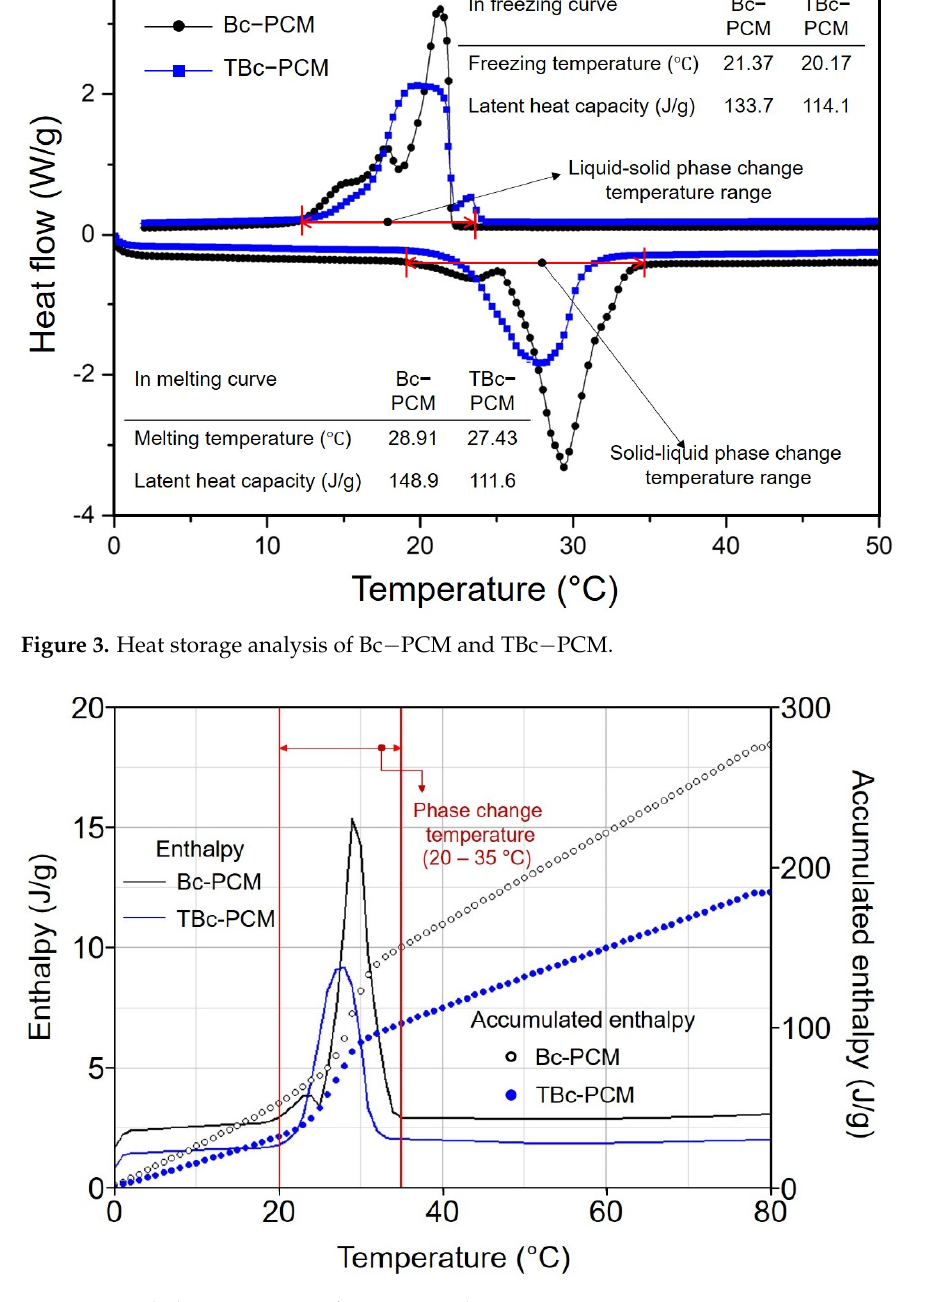
Figure 5. Thermal durability analysis of Bc-PCM and TBc-PCM. 3.3. Energy Simulation Analysis 3.3.1. Annual Heating and Cooling Load Reduction Table 4 represents the annual heating and cooling energy consumption of the building models in which Bc-PCM and TBc-PCM were applied with thicknesses of 10 to 30 mm for the four cities. In this study, the reference model represents a conventional wooden frame house in which Bc-PCM and TBc-PCM are not applied to the wall. In Design Builder, the energy consumption of the building was estimated based on gas consumption for heating and electricity consumption for cooling. As shown in Table 4, the annual heating and cooling energy consumption shows a lower heating and cooling energy consumption as the thickness of the PCM layer increases. On the other hand, the